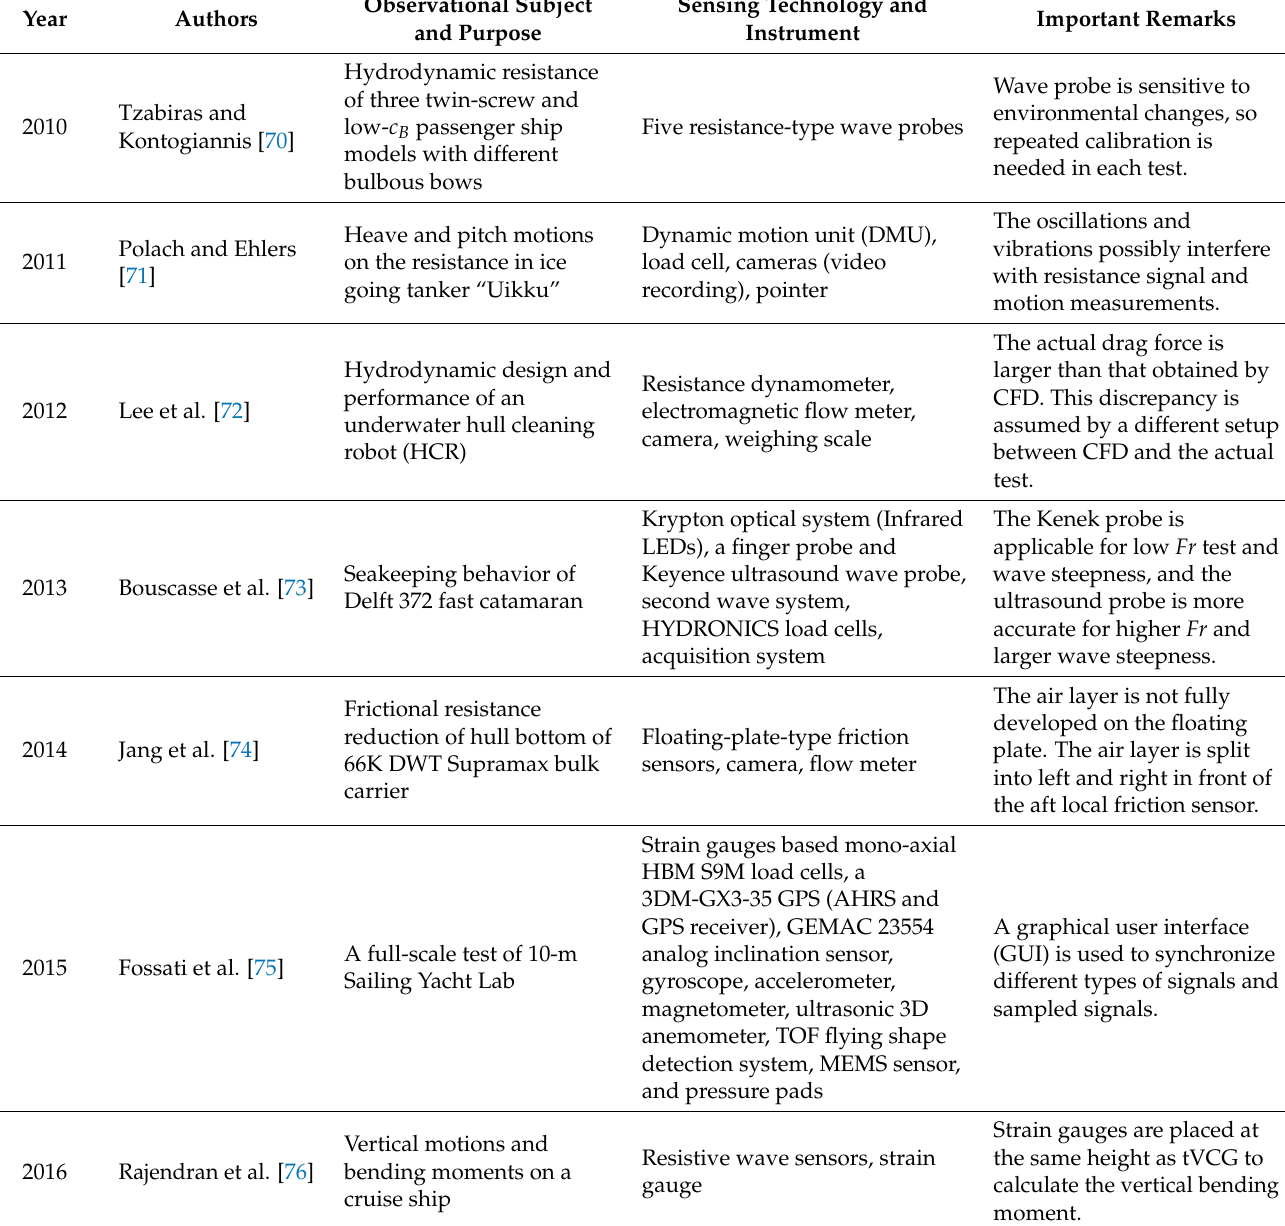
Table 3. Landmark research on the sensing technology for hydrodynamic characterization in marine